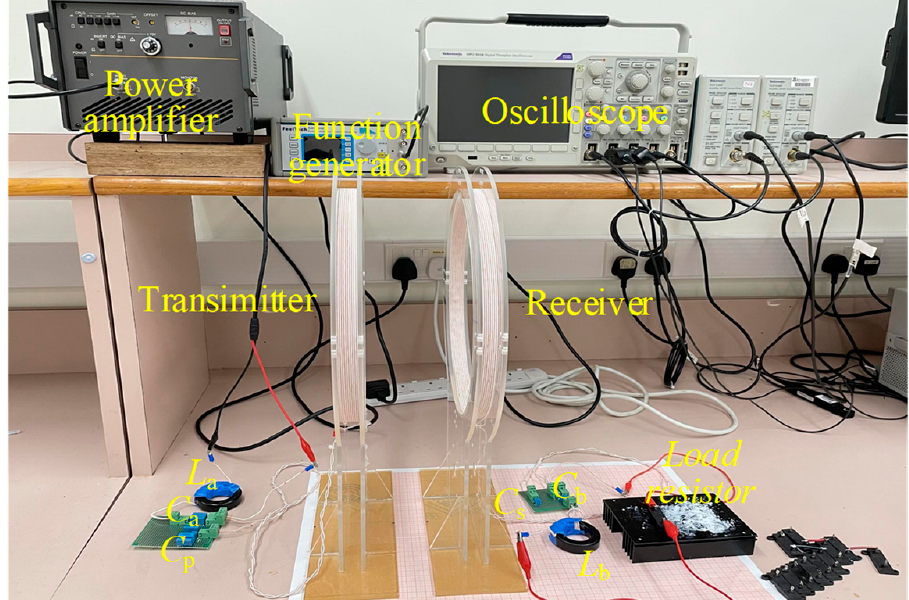
Figure 11. Experimental prototype.